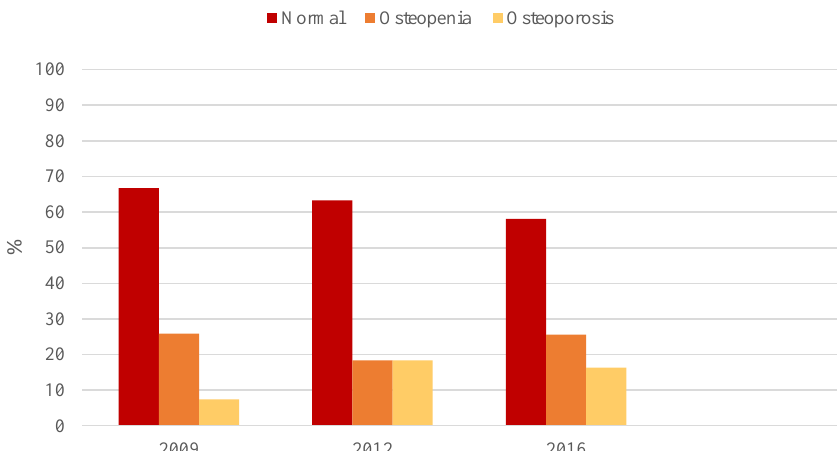
Figure 2. Lumbar bone mineral density grouped according to the World Health Organization (WHO) classification during the study period. Table 3. Densitometric data of SCD patients.